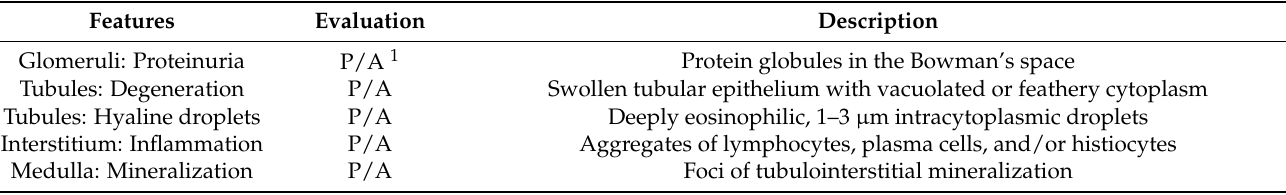
Table A6. Histopathological features evaluated in the kidney.